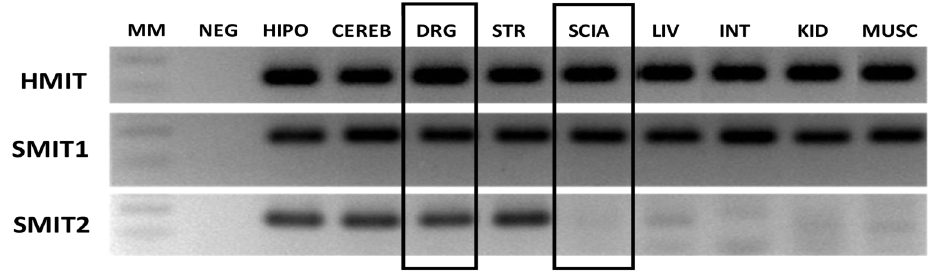
Figure 2. Sodium myo-inositol cotransporters 1 and 2 (SMIT1, SMIT2), and H + /myo-inositol cotransporter (HMIT) detection by regular PCR and ethidium bromide-stained agarose gels on mRNA extracted from sciatic nerve (SCIA) and dorsal root ganglia (DRG), hippocampus (HIPO), cerebellum (CEREB), striatum (STR), liver (LIV), intestine (INT), kidney (KID), and skeletal muscle (MUSC). Total RNA (1000 ng) was loaded into each lane, except for SCIA (250 ng) and DRG (500 ng).